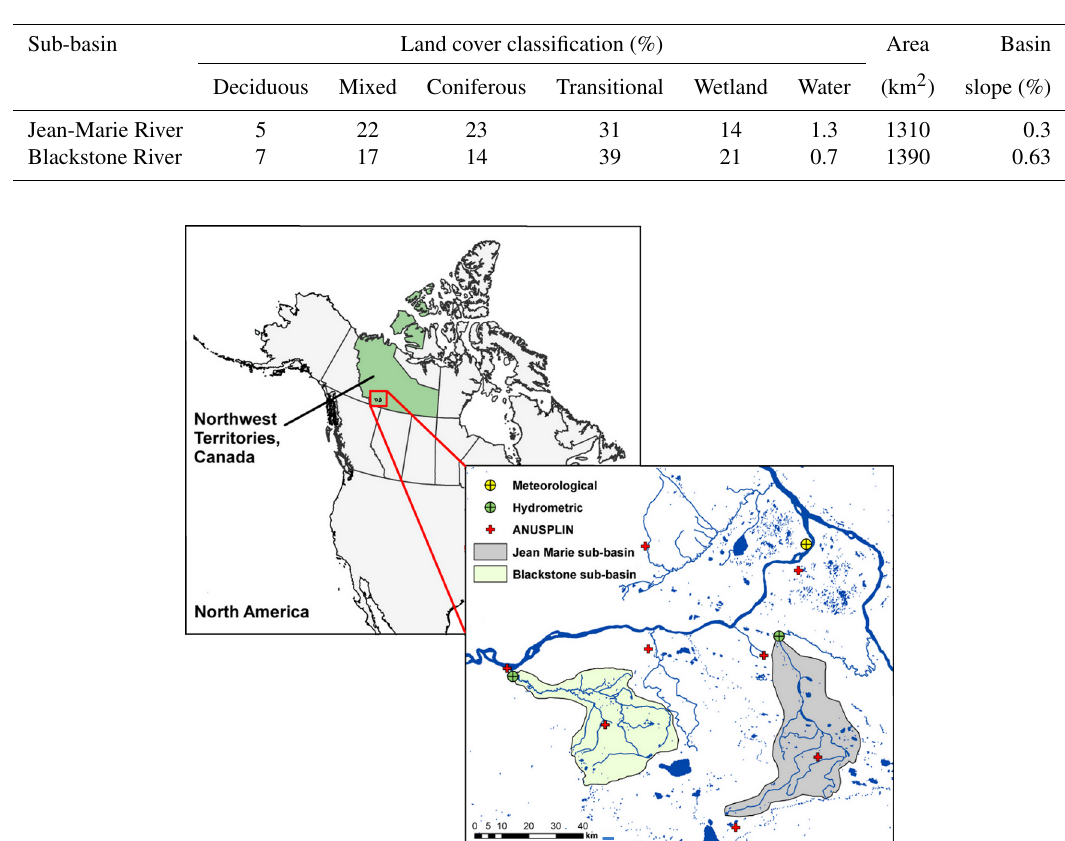
Table 1. Basin characteristics, including land cover classification, area, and average basin slope (recreated from data provided in St Amour et al., 2005).